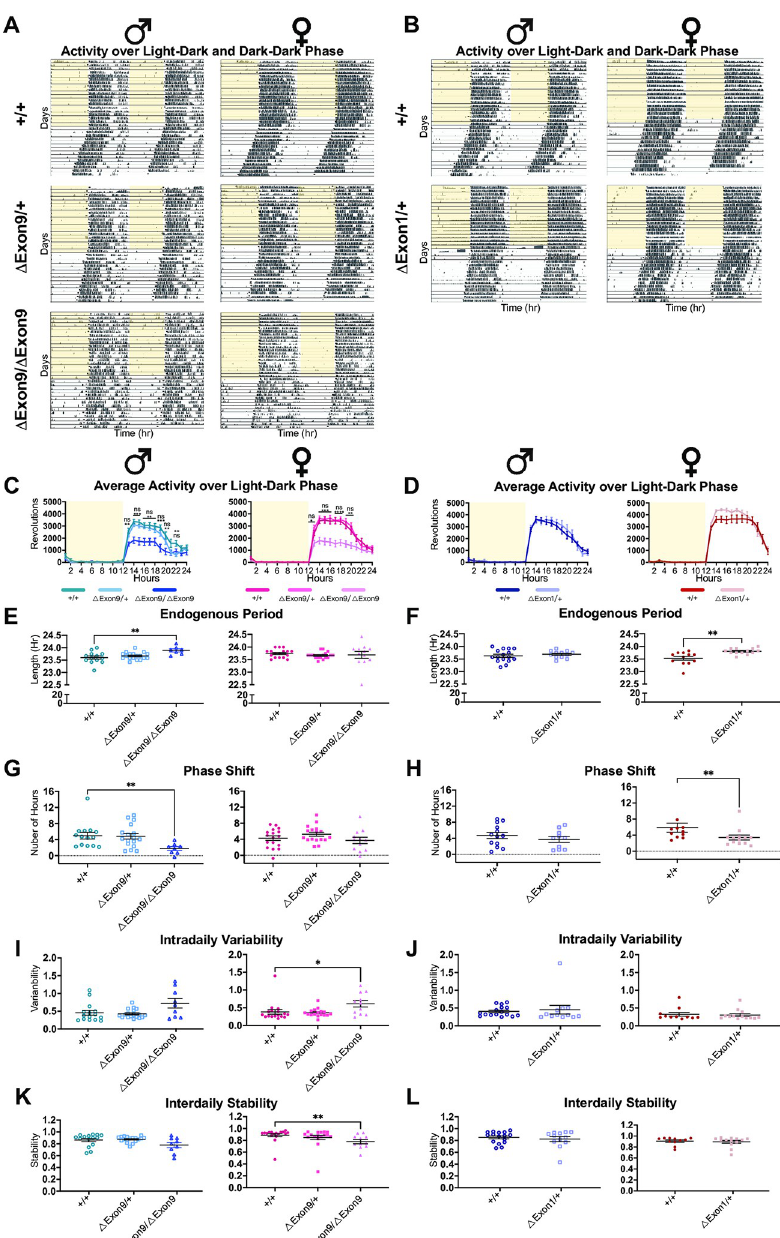
Fig 4. A reduction in Nrxn1 α expression alters circadian locomotor activity. A-B. Representative actograms from mice under two different lighting conditions: (1) 12 h of light (indicated by the yellow shading) followed by 12 h of dark (L/D) and (2) constant dark (D/D). Actograms depict locomotor activity (wheel revolutions) across time with days stacked vertically and double plotted with the x axis spanning 2 days (48 hours). Grey squares indicate activity onsets. C-D. Activity profiles averaged over 5 consecutive days of L/D conditions across sex and genotype. Repeated measures two-way ANOVA test with Tukey’s multiple comparisons test (C) or Sidak’s multiple comparison test (D). � p < 0.05; �� p < 0.01; ��� p < 0.001; ���� p < 0.0001. E-F. Endogenous period across sex and genotype. (E) Mean endogenous periods per group: male +/+, 23.60; male Δ Exon9/+, 23.67; male Δ Exon9/ Δ Exon9, 23.89; female +/+, 23.75; female Δ Exon9/+, 23.66; female Δ Exon9/ Δ Exon9, 23.69. Kruskal-Wallis test with Dunn’s multiple comparison test; �� p < 0.01. (F) Mean endogenous periods per group: male +/+, 23.63; male Δ Exon1/+, 23.69; female +/+, 23.53; and female Δ Exon1/+, 23.81. Welch’s t test; �� p < 0.01. G-H. Phase shift across sex and genotype. (G) Kruskal-Wallis test with Dunn’s multiple comparison test; �� p < 0.01. (H) Mann-Whitney U test; �� p < 0.01. I-J. Intradaily variability in the L/D phase across sex and genotype. (I) Kruskal-Wallis test with Dunn’s multiple comparison test; � p < 0.05. (J) Mann-Whitney U test. K-L. Interdaily stability in the L/D phase across sex and genotype. (K) Kruskal-Wallis test